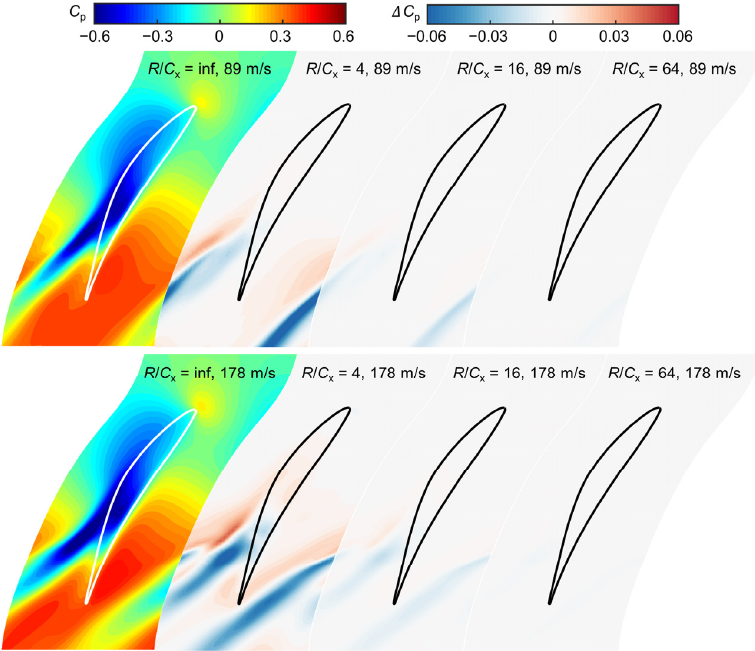
Figure 10. Endwall static pressure coefficient and its difference at various disk radii.